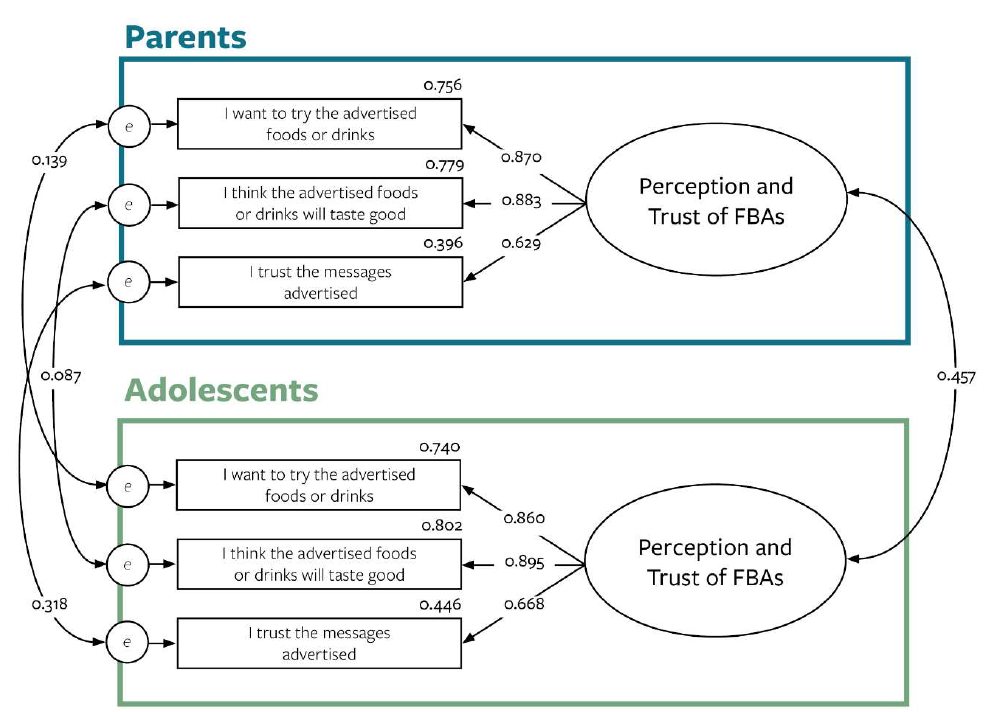
Figure 2. Perceptions and trust of FBAs set as latent variables. Variables in the blue box reflect the measurement model for parents while variables within the green box reflect the model for adolescents. R 2 values are provided above each indicator. Key: rectangles = indicators; ellipses = latent variables; small circles = residual errors; curved double-ended arrows = covariances; straight single-ended arrows = directional paths.